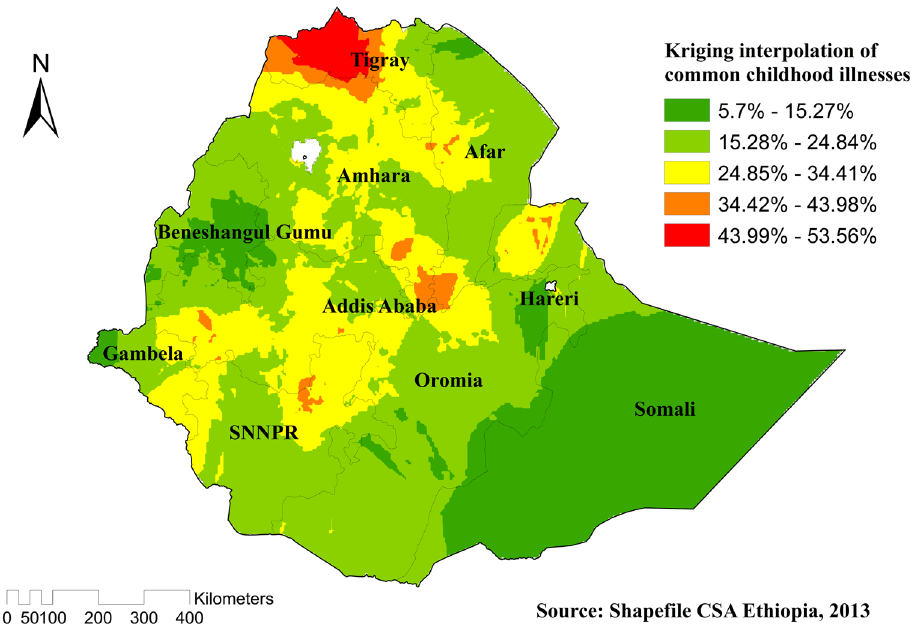
Figure 5. Kringing interpolation of common childhood illnesses among under-five children in Ethiopia, 2016